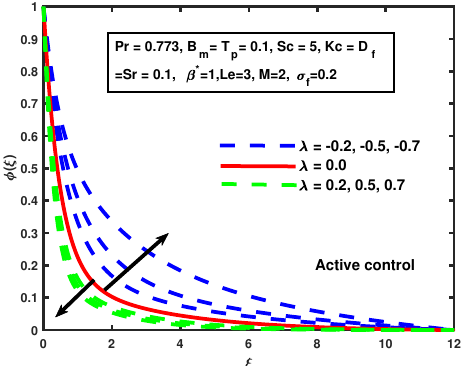
Figure 16. The impact of φ ( ξ ) on suction/injection λ (active control case).